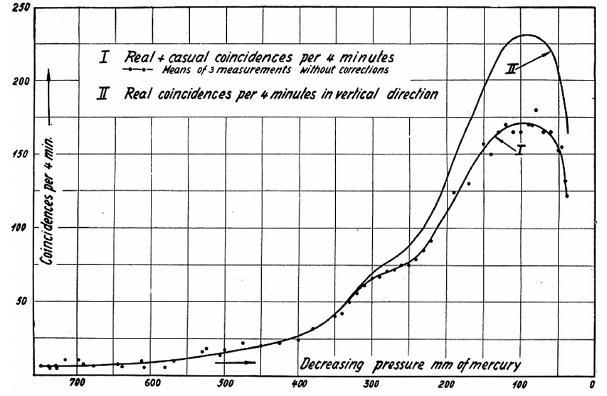
Figure 5. Data from coincidence measurements by Regener and Pfotzer (1935). The coincidence rate per 4min at a solid angle of 20 degrees about the zenith is shown as function of decreasing pres- sure (mm Hg) (data points and line I). Data, corrected for dead- time losses, are shown as line II. Note the clear maximum at about